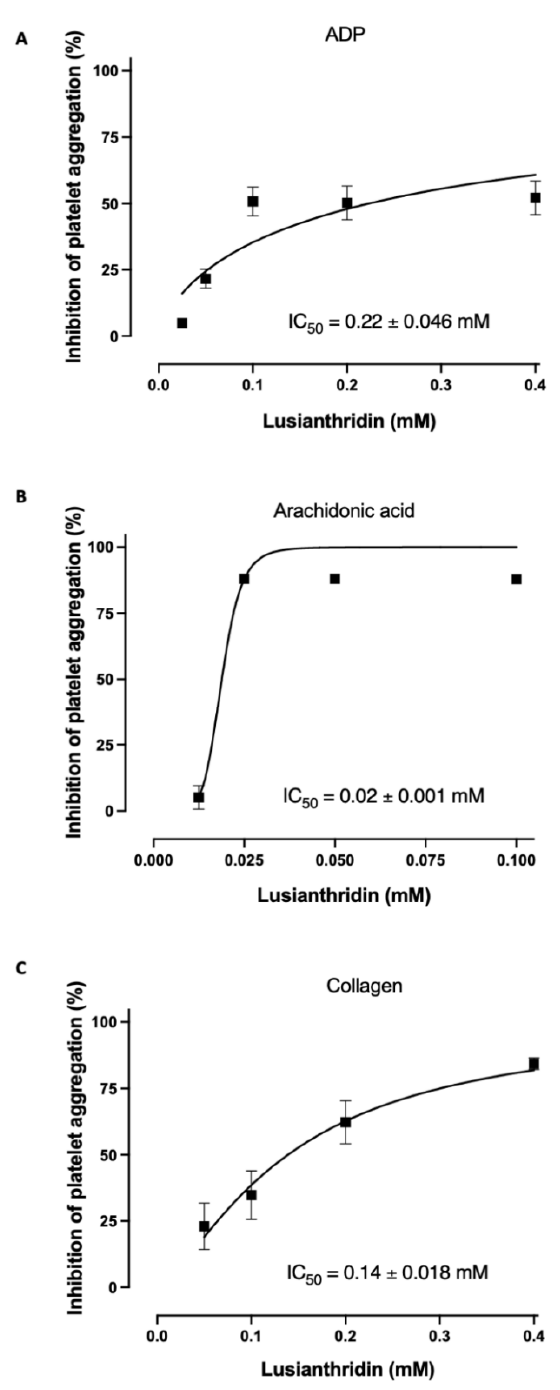
Figure 2. Lusianthridin concentration-dependently inhibited platelet aggregation induced by ( A ) ADP 4 µM, ( B ) Arachidonic acid 0.5 mM, and ( C ) Collagen 2 µg/mL. Data are presented as percent inhibition of platelet aggregation (means ± SEMs; n =